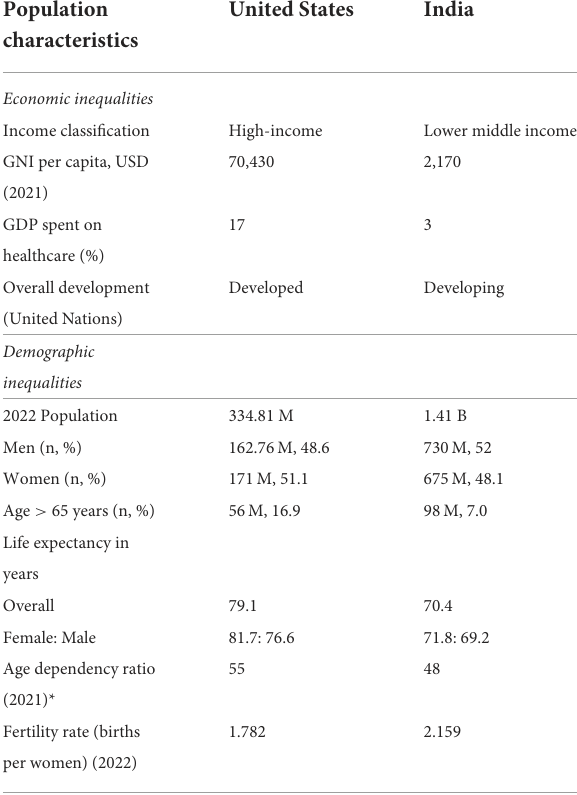
TABLE 1 Economic and demographic inequalities in the United States vs. India.